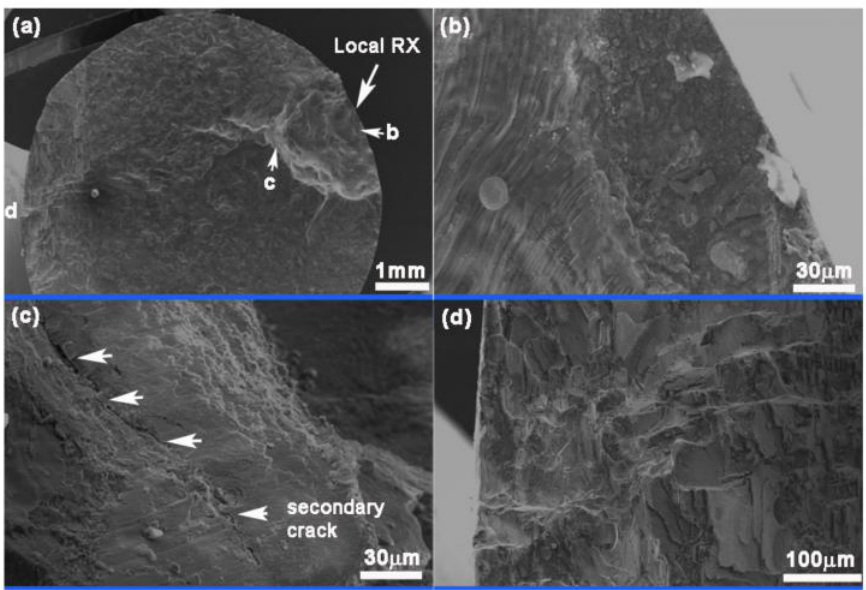
Figure 9. Fatigue fracture of a single crystal alloy with local recrystallization at 850 ◦ C ( N f = 5235 cycles) ( a ) overview of fracture surface; ( b ) surface oxidation; ( c ) secondary cracking; ( d ) fracture at a high ∆ K